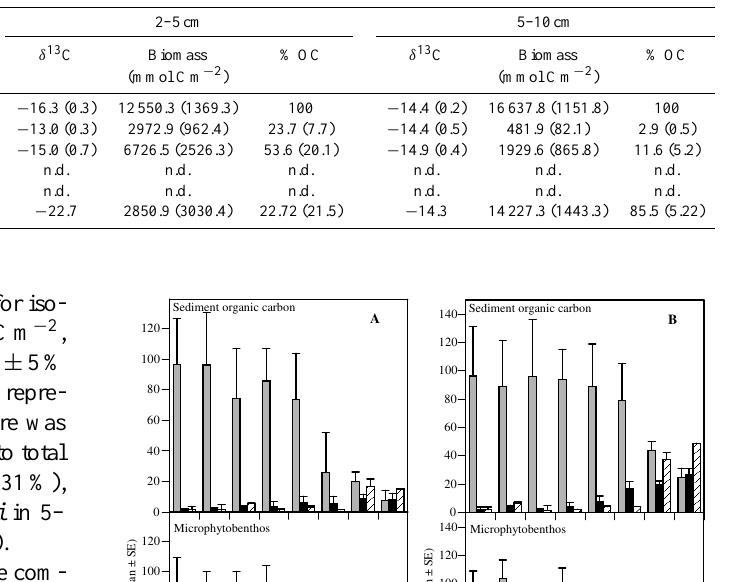
Table 1. Mean natural abundance carbon stable isotope ratios ( δ 13 C), biomass (standard errors in brackets), and % of sediment organic carbon (% OC) represented by sediment compartments at depths of 0–2cm, 2–5cm and 5–10cm, based on control samples. Note that δ 13 C values for bacteria and MPB are for whole cells. Units are per area, not volume. δ 13 C of uncharacterized material estimated using isotope mixing models. Sample size for all means and standard errors = 6.